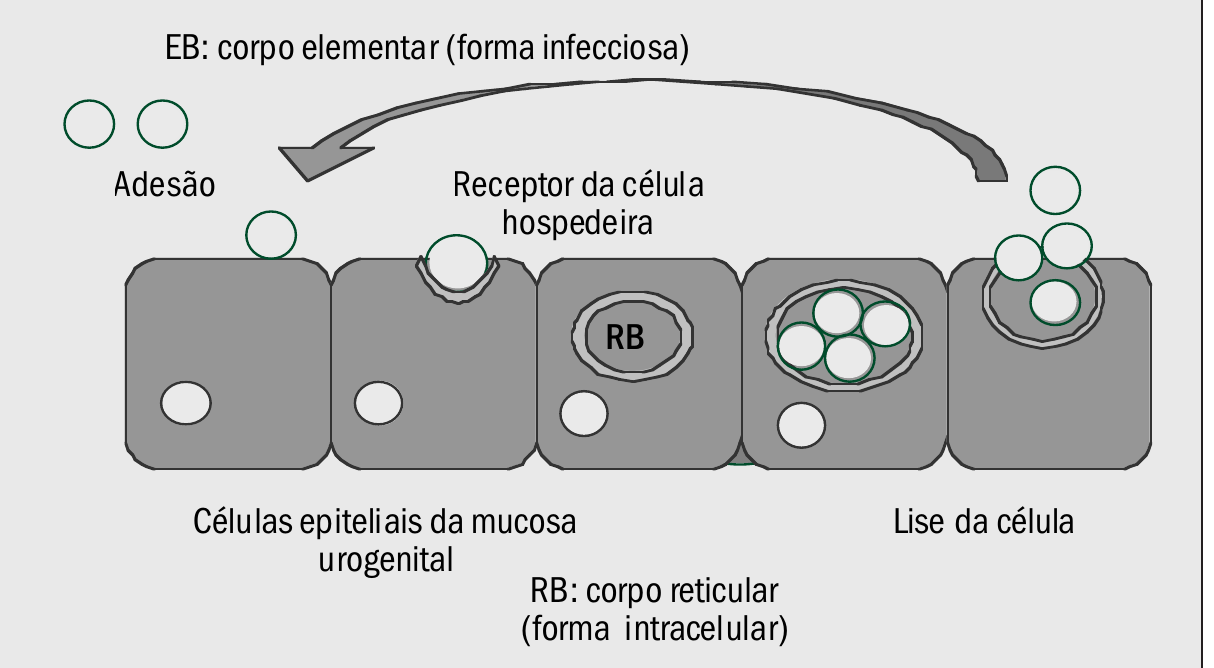
Figura 1 – Ciclo de desenvolvimento da Chlamydia